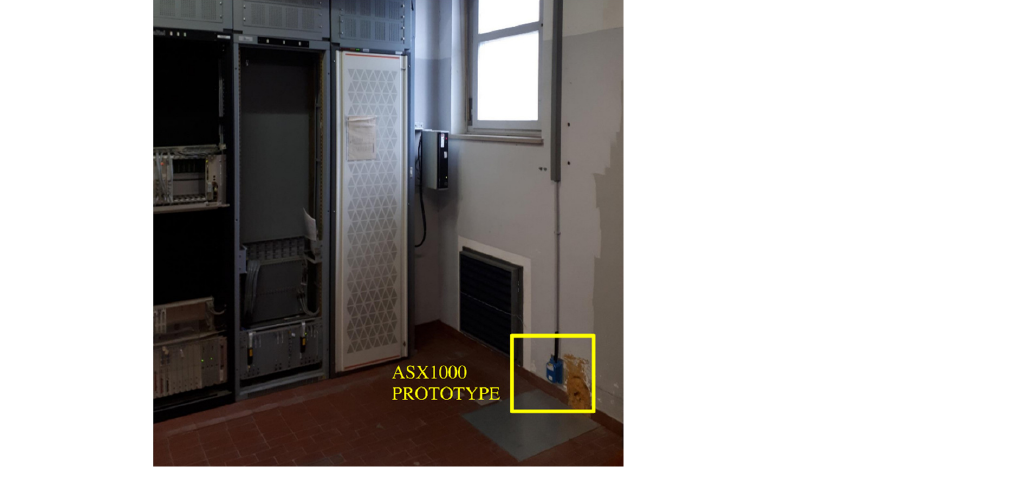
Figure 3. The ASX1000 prototype (yellow square) installed inside a local telecommunication infrastructure.